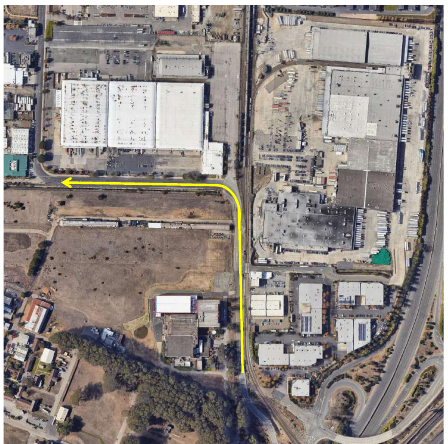
Figure 6. Urban environment and moving path of the target in the GAZEBO simulation. Before geolocating the moving target using multiple images, including the past im- ages, the corresponding points in the past images were matched using the corresponding- point-matching method described in Section 2.3. The accuracy of the corresponding- point-matching method proposed in this paper depends heavily on the estimation of the fundamental matrix F , and wrong corresponding point matching will cause an error in target geolocation. However, the estimation of the fundamental matrix is occasionally inaccurate due to the matching error of ORB features between the current image and the past image. Therefore, the method of filtering the wrong corresponding points is proposed in Section